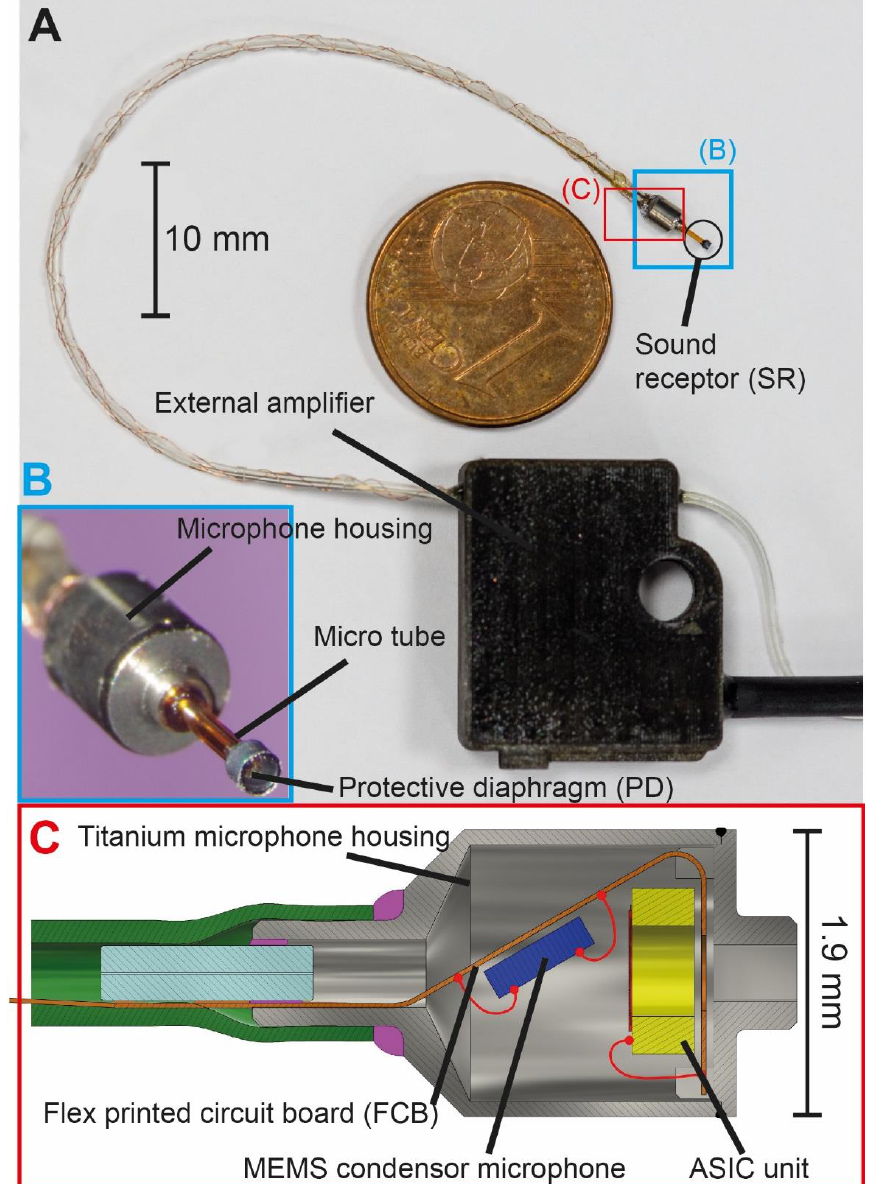
Figure 1. ( A ) Photograph of the completely assembled ICAR, ( B ) Zoomed-in view of the ICAR head, ( C ) Schematic drawing of the microphone housing cross section. ( C ) Schematic drawing of the microphone housing cross